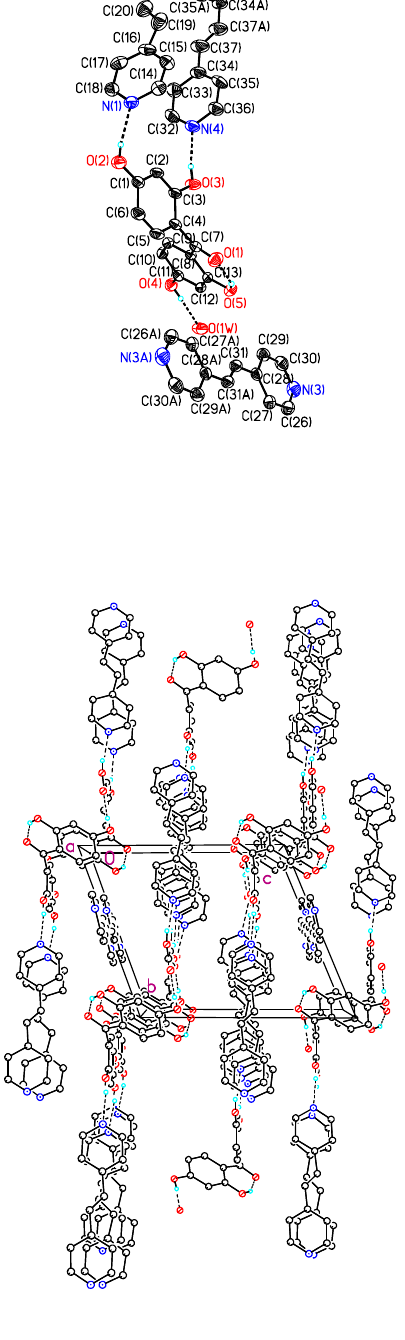
Figure 6 (a) The crystal structure of 6 . Hydrogens were omitted for clarity. (b) The crystal-packing of 6 viewed down the a axis. Notice that 6 leads to a zigzag